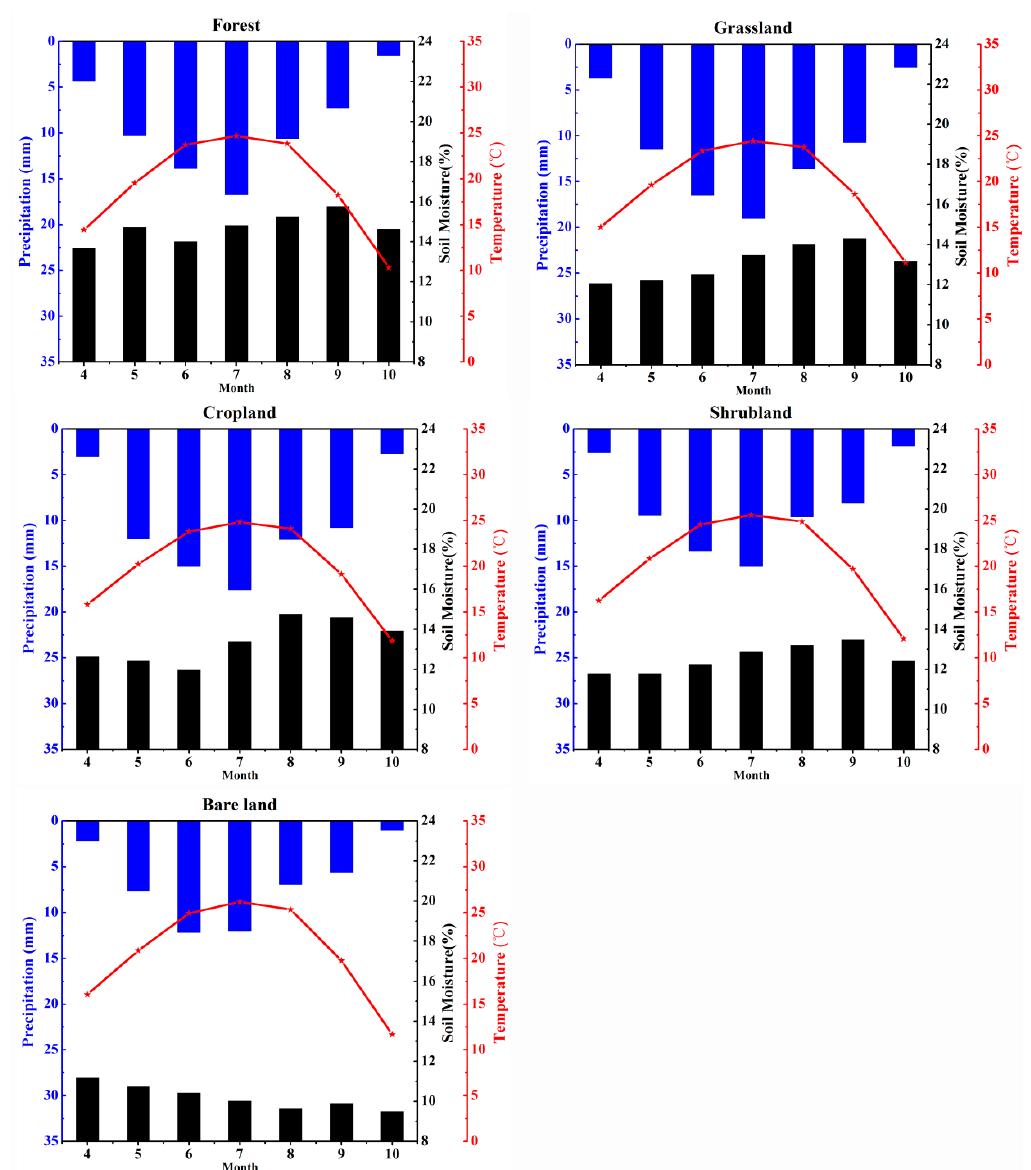
Figure 9. Monthly variations of soil moisture, precipitation, and temperature in different land cover types from April to October.